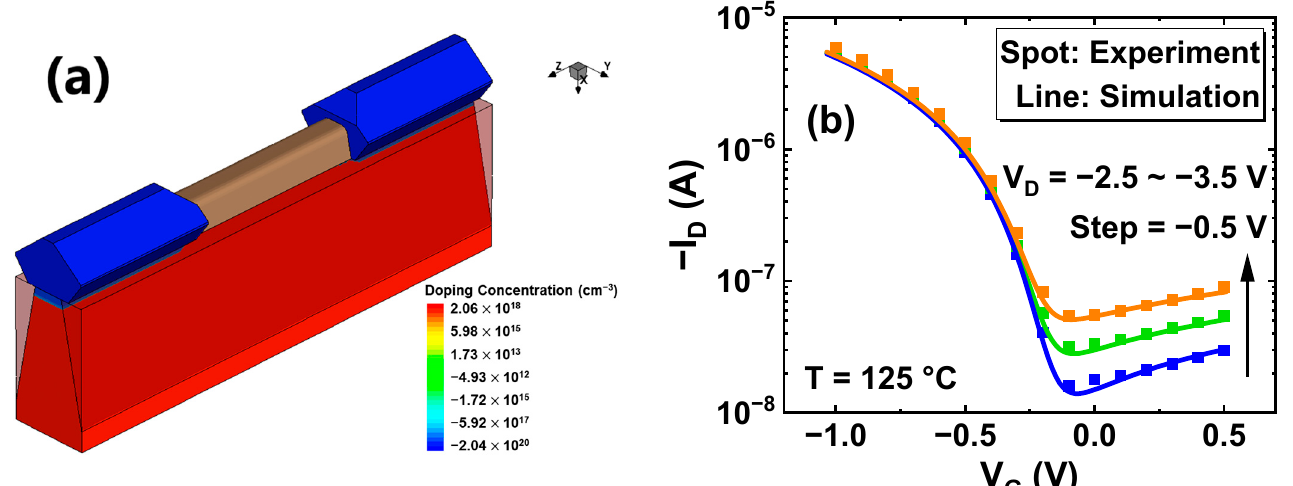
Figure 3. ( a ) 3-D simulation structures of Bulk FinFET with 100 nm gate length. ( b ) TCAD calibration of Bulk FinFET I D -V G and GIDL characteristics with experimental data. Orange curve: V D = − 3.5 V. Green curve: V D = − 3.0 V. Blue curve: V D = − 2.5 V.